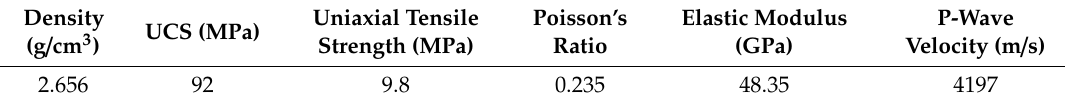
Figure 7. Uniaxial compression samples. Table 1. Physical and mechanical parameters of the rock.